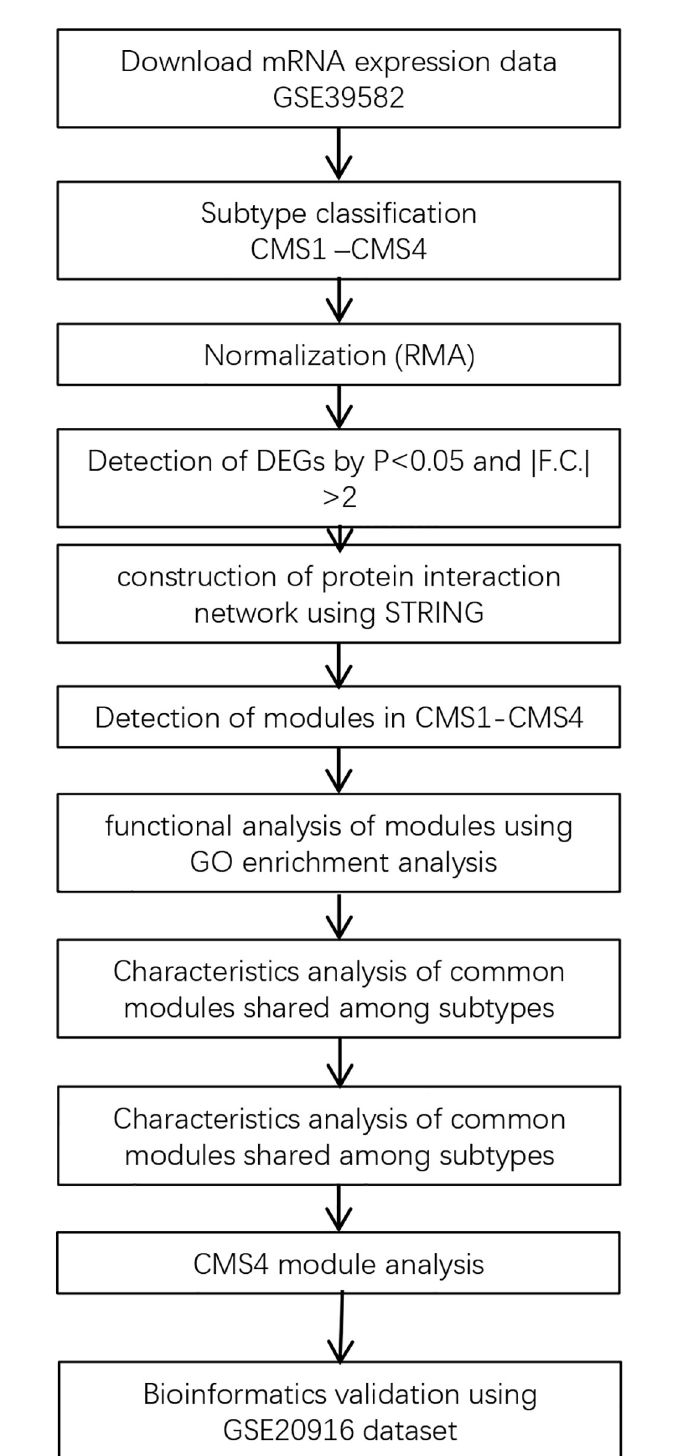
Fig 1. Schematic workflow of the bioinformatics pipeline used for the search of significant modules in this study.